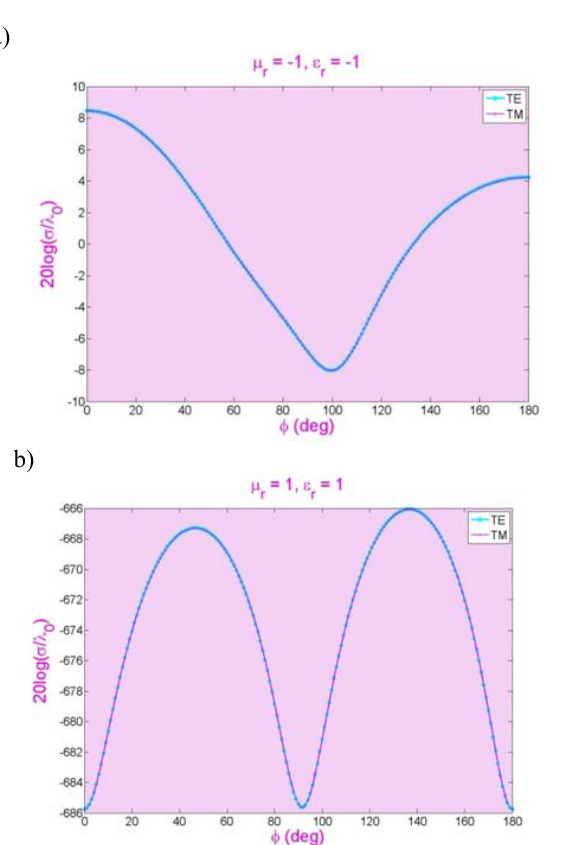
Figure 7: Normalized bistatic echo widths for (a) DPS materials (b)